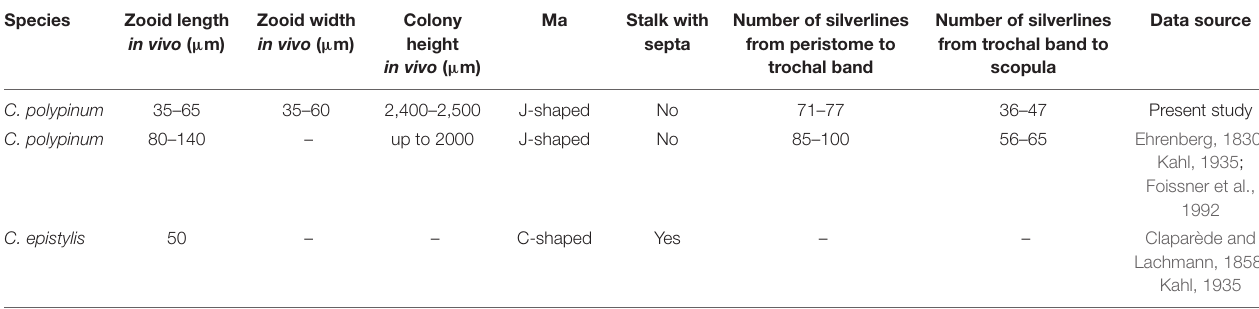
TABLE 6 | Comparison of Carchesium polypinum (Qingdao population) with other populations and closely related congener. Species Zooid length in vivo ( µ